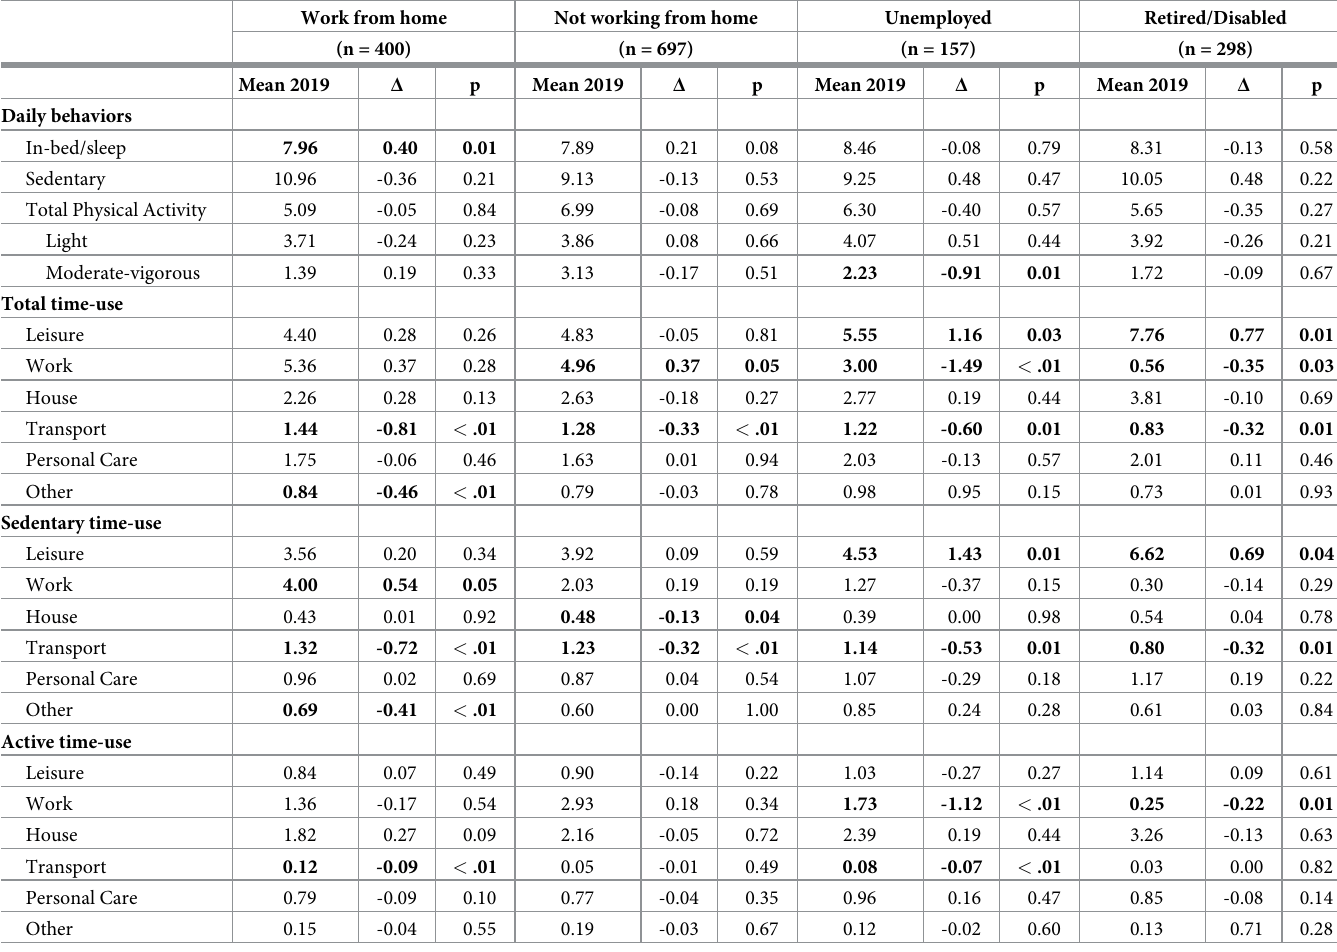
Table 4. Changes ( Δ ) in daily behaviors and time-use (hrs/d) between 2019 and 2020, by occupational and work from home status in 2020—US adult. Work from